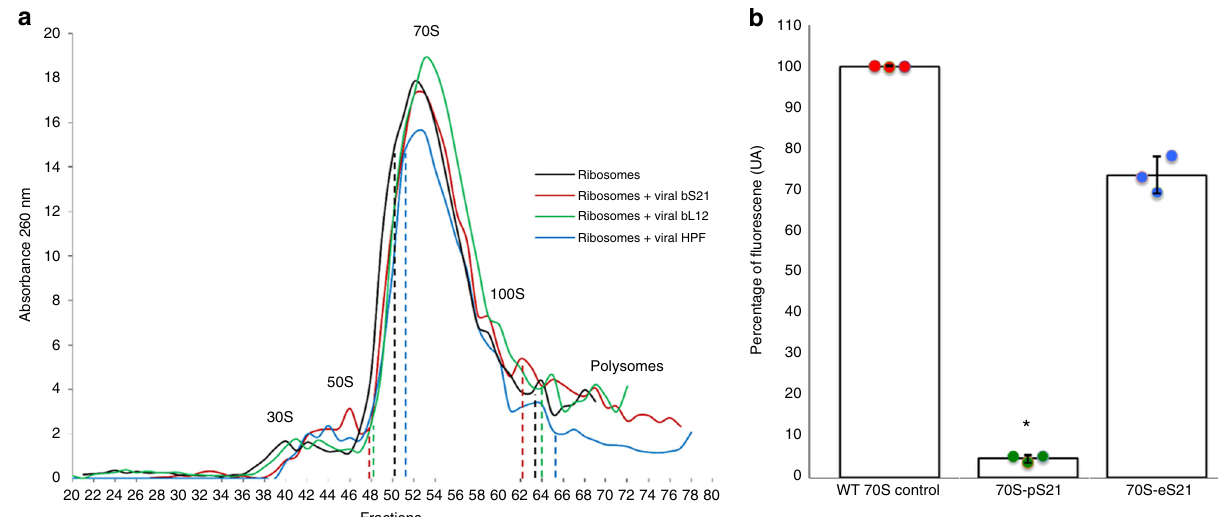
Fig. 4 Ribosome analysis of extracts from NM522 Escherichia coli cells. a Sedimentation pro fi les of NM522 E. coli ribosomes. Wild-type NM522 E. coli cells (black curve) and cells expressing viral bS21 (red), bL12 (green) or HPF (blue) were lysed and their ribosomes were puri fi ed using a 10 – 50% sucrose gradient (see experimental section). The dotted lines indicate the fractions that were pooled and further analyzed by mass spectrometry. b Quanti fi cation of in vitro translation of GFP by E. coli 70S ribosomes carrying either E. coli wt bS21 (control), E. coli streptavidin-tagged bS21 (70S-eS21) or viral streptavidin-tagged bS21 (70S-pS21). Translation assay was performed using PURExpress ® Δ Ribosome Kit, complemented with 10 pmol of puri fi ed ribosomes and 250 ng of a PCR product encoding for GFP under control of T7 promoter. Fluorescence signal was detected by spectro fl uorimetry at 510 nm with an excitation at 485 nm. The percentage of fl uorescence was measured with respect to the translation control. The error bar represents the standard deviation measured over three independent experiments. The variance was analyzed using Kruskal – Wallis test followed by a Dunn ’ s multiple comparison test ( p -value for 70S-pS21 = 0.0219)